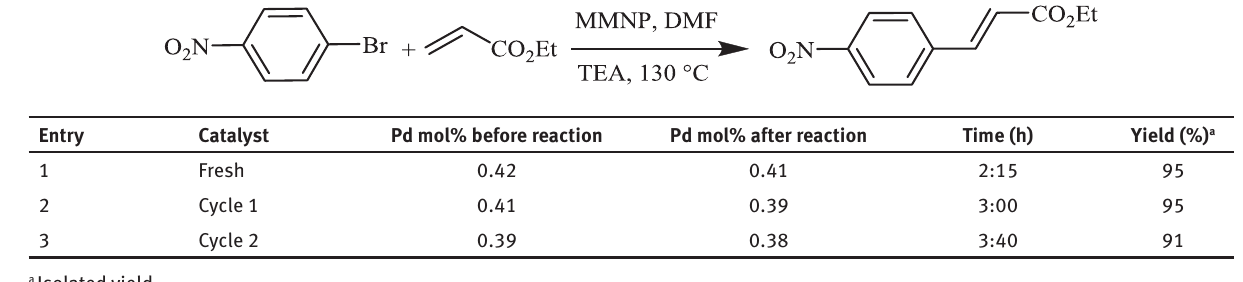
Table 6: Recovery and reuse of MMNP for the Heck